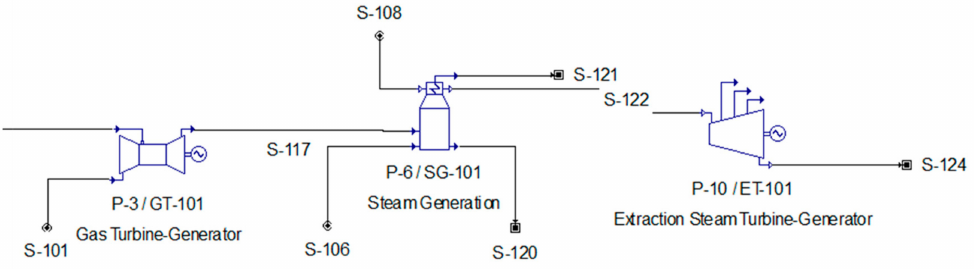
Figure 3. Process flow diagram of the CHP in SuperPRO Designer.